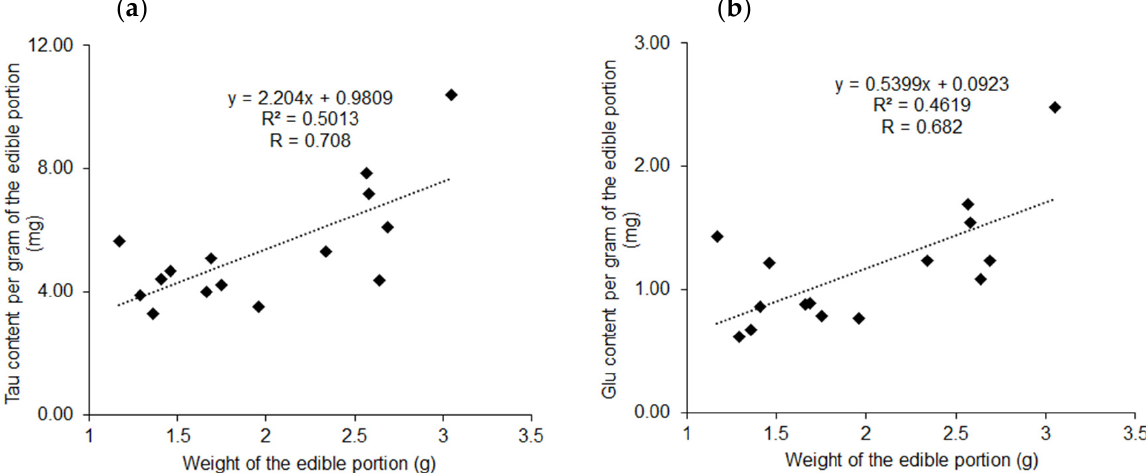
Figure 7. Scatter plot of the weight of the edible portion and Tau ( a ) or Glu ( b ) content per 1 g of the edible portion. Vertical axis: Tau ( a ) or Glu ( b ) content per gram of edible portion (mg); Horizontal axis: weight of the edible portion (g).